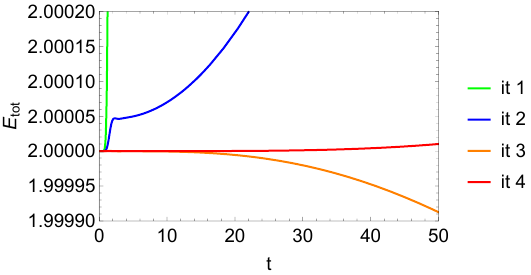
Figure 17 . The total energy is plotted for various iterations with initial conditions given by (4.16) with it 1 standing for first iteration, etc. We get convergence in 4 iterations as evident from the total energy being constant in the fourth iteration to a very good